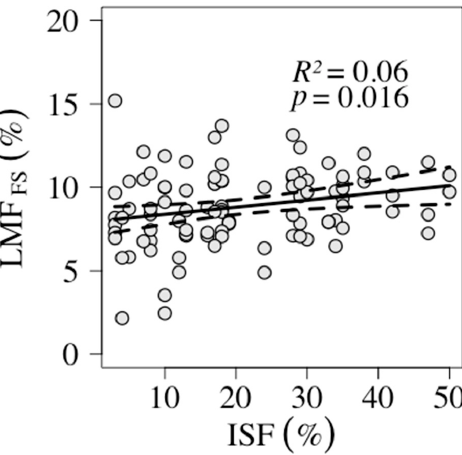
Figure 3. Leaf mass fraction (LMF) of F. sylvatica seedlings (FS) from fenced plots in association with indirect site factor (ISF). The sample-size was n = 98. Black solid line shows the trend and the shaded grey area shows the 95% confidence interval. R 2 and the p -value were extracted from the GLM (generalized linear model). Table 3. Results from generalized linear models (GLM) for seedlings growth response analysis in regard to light (model: y ~ ISF). Results for F. sylvatica and T. cordata with light (ISF) as influencing